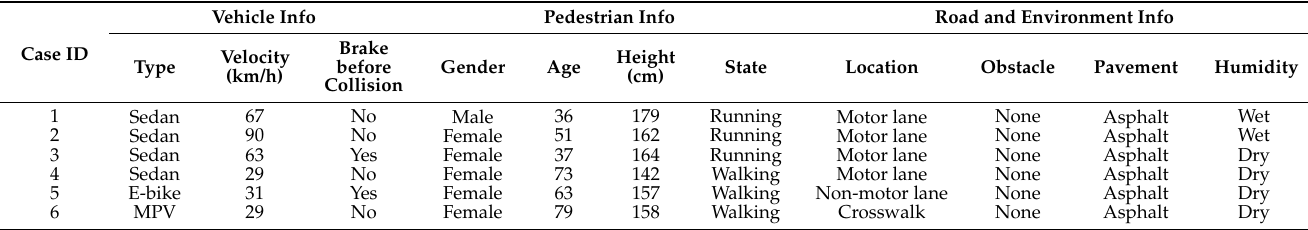
Figure 2. Workflow implemented for the pedestrian accident reconstruction. Table 1. Key parameters related to these accidents.